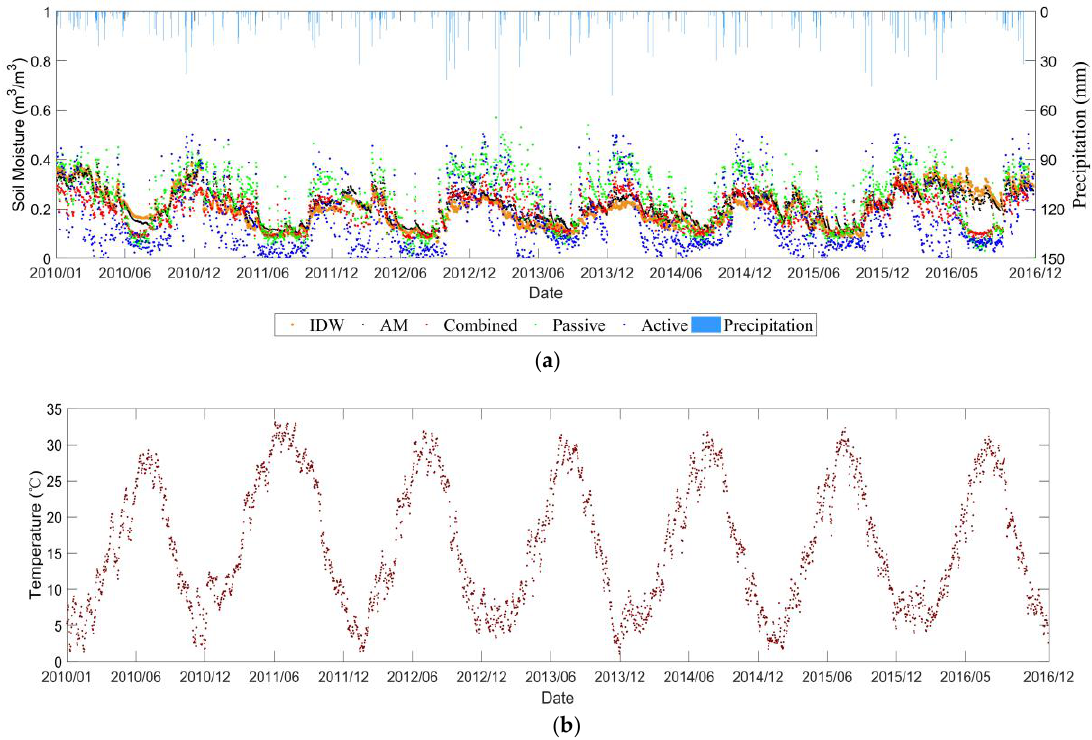
Figure 9. Temporal evolutions of ( a ) CCI retrieved and in-situ measured soil moisture ( b ) temperature in the REMEDHUS network.